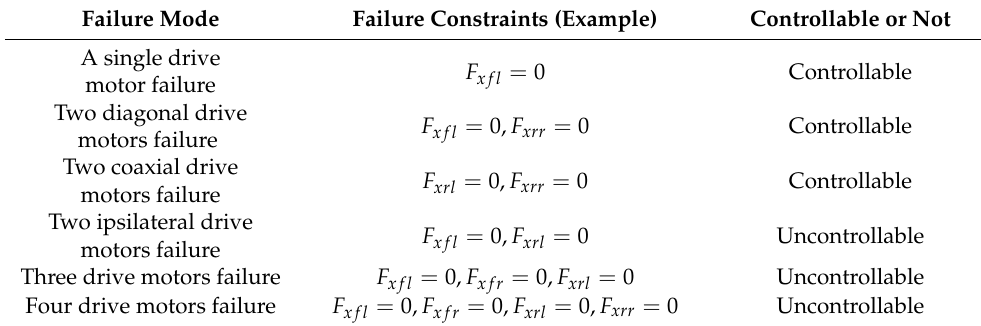
Table 1. Failure mode control